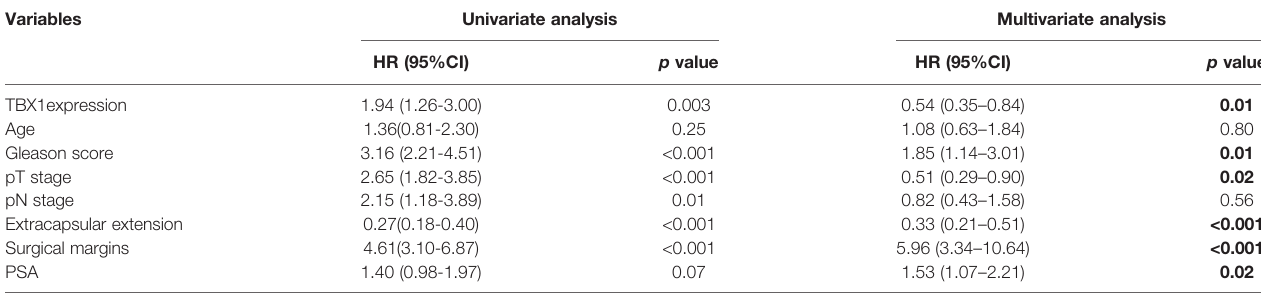
TABLE 2 | Association of various parameters with BCR-free survival in 280 patients with PCa on univariate and multivariate analyses. Variables